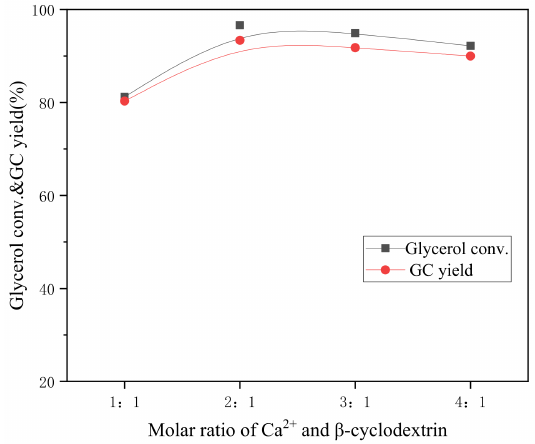
Figure 5. Effect of molar ratio of Ca 2+ and β -CD on glycerol conversion and GC